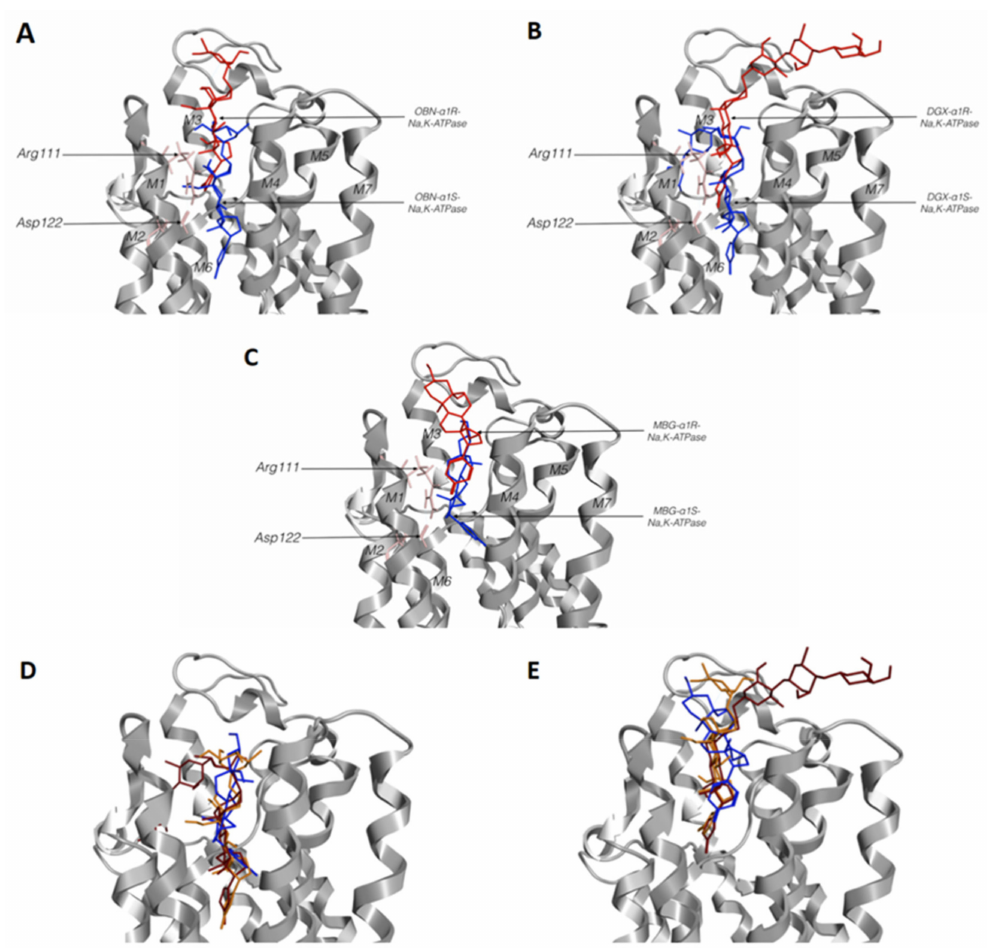
Figure 4. Superposition of cardiotonic steroids (CTSs) in α 1S- and/or α 1R-Na,K-ATPase docking models. CTSs’ positions in the CTSs-binding site of α 1S and α 1R-Na,K-ATPase for: ( A )—ouabain, ( B )—digoxin, ( C )—marinobufagenin. Arg111 and Asp122 are colored in pink, CTSs interacting with α 1R-Na,K-ATPase are colored red, with α 1S-Na,K-ATPase colored in blue. ( D )—Position of ouabain (orange), digoxin (red) and marinobufagenin (blue) in α 1S-Na,K-ATPase. ( E )—Position of ouabain (orange), digoxin (red) and marinobufagenin (blue) in α 1R-Na,K-ATPase. Models based on the 4HYT structure of Na,K-ATPase. OBN—ouabain; DGX—digoxin;